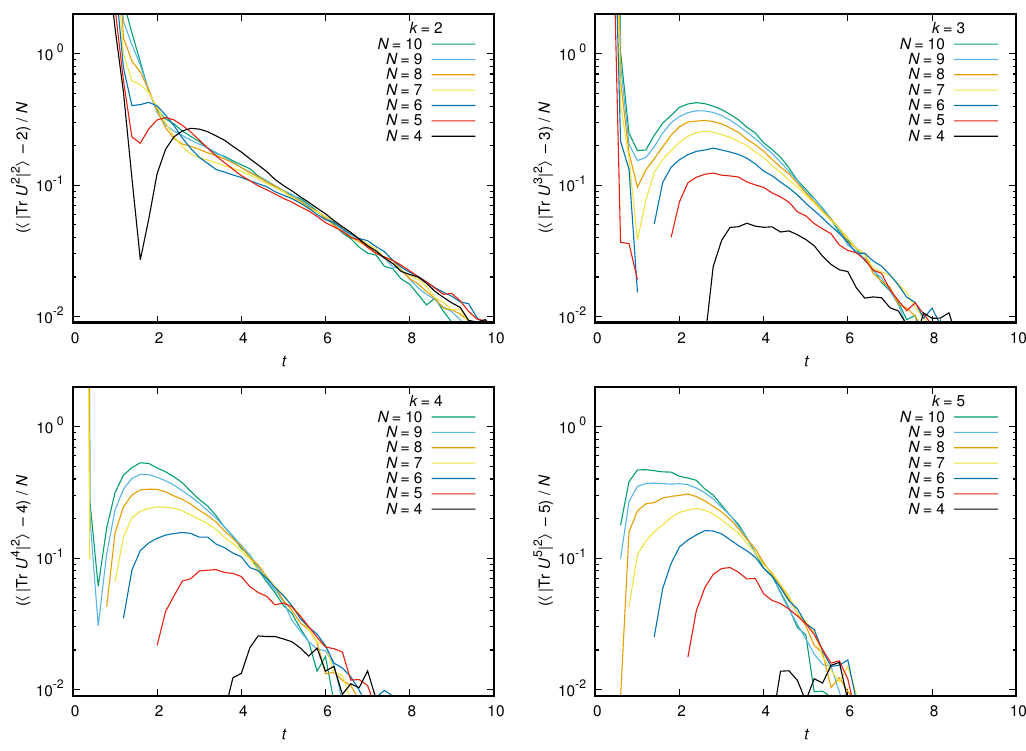
Figure 19 . Plot of ( hj Tr U k (~ t ) j 2 i (cid:0) k ) =N against t for various values of N , k = 2 ; 3 ; 4 ;